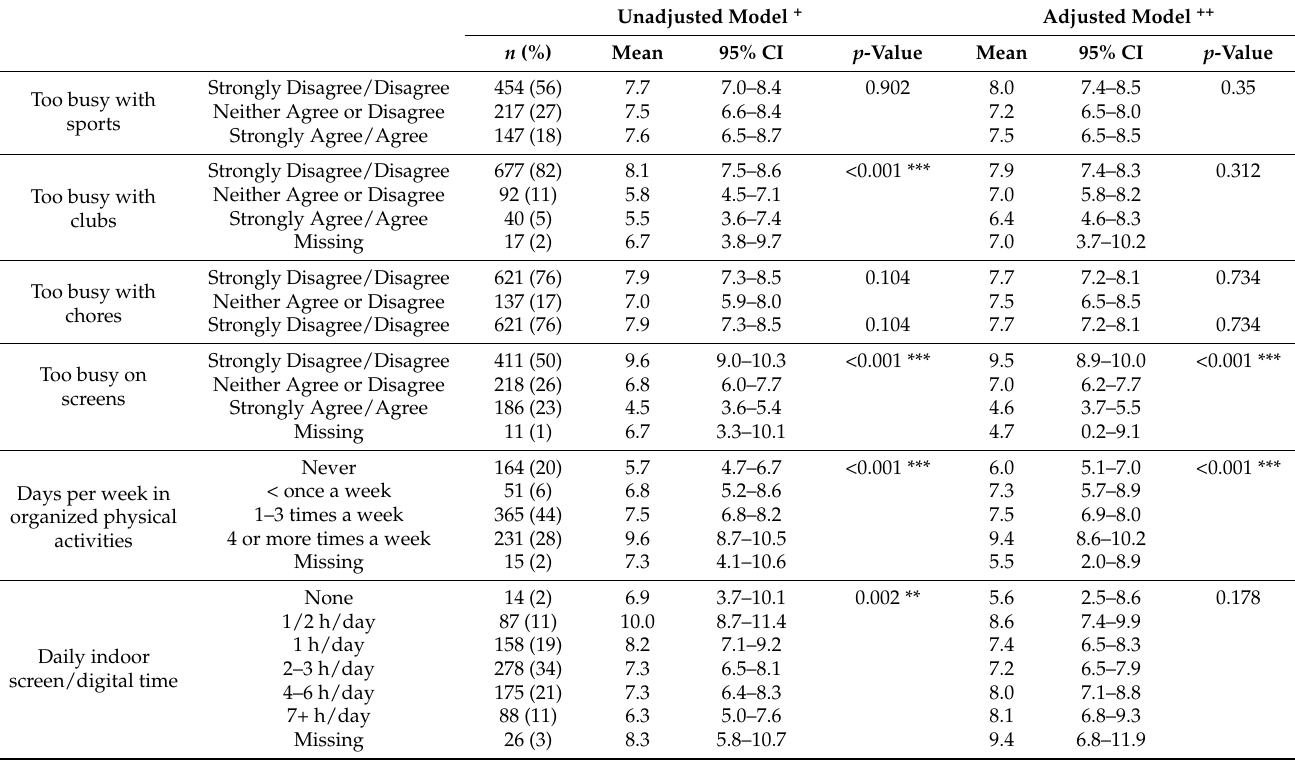
Table 4. Time Available for Outdoor Free Play: Descriptives and Model 2 Results. Adjusted model controls for demographic variables in Model 1 (Table 3) 1